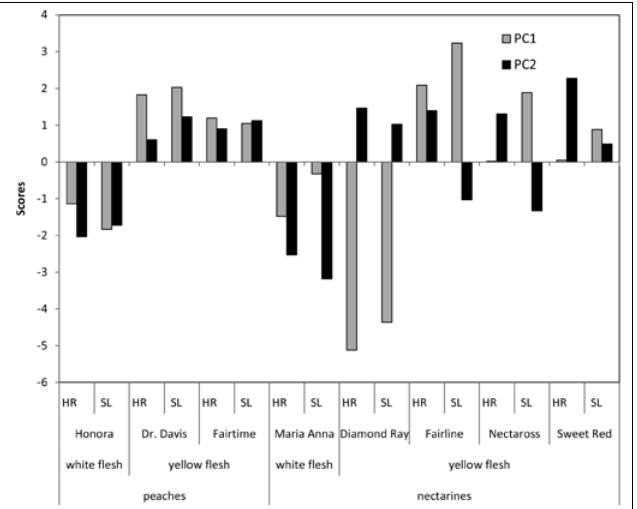
Fig. 5 - PCA scores on PC1 and PC2 of peach and nectarine cultivars evaluated at harvest (HR) and after shelf-life (SL). Bars repre- sent standard